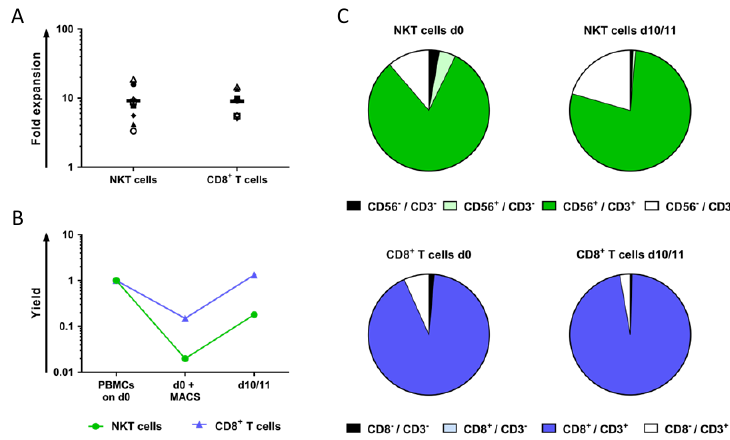
Figure 1. Natural killer T (NKT) cells can be isolated from peripheral blood mononuclear cells (PBMCs) and expanded by using CD3 monoclonal antibody (OKT-3) and interleukin-2 (IL-2). The NKT cells were derived from peripheral blood mononuclear cells (PBMCs) from healthy donors via magnetic-activated cell sorting (MACS). The CD8 + T cells were obtained from the NKT-negative cell fraction. Both of the cell populations were then stimulated with OKT-3 and IL-2 for 10 – 11 days. During expansion, IL-2 was added on days 2, 3, 5, and 7. The cells were counted on day 3 and re-adjusted to a concentration of 0.2 × 10 6 cells per ml using fresh culture medium. On day 7, the total cell culture volume was doubled by adding fresh culture medium, and half of the total volume was transferred to a second culture flask. After expansion, the cells were counted, and the fold expansion was calculated by dividing final cell count by the initial number of cells at the beginning of stimulation. Prior to and after expansion, the NKT cells were double stained for CD56 and CD3, and the CD8 + T cells were double stained for CD8 and CD3. ( A ) The fold expansions of 7 – 8 independent experiments, each depicted as a different symbol, are shown. The resulted values are presented on a logarithmic scale. The mean values are shown as bars. ( B ) Yield of the NKT cells (green circles) and CD8 + T cells (blue triangles) before and after MACS isolation and final expansion with OKT-3 and IL-2 calculated per 1 × 10 6 PBMCs. The resulted values are presented on a logarithmic scale. The average values of 6 – 8 independent experiments are displayed. The absolute values are listed in Table S1. ( C ) The composition of the cell subpopulations at the beginning and the end of expansion. The NKT cells were double stained for CD56 and CD3 (upper part), and the CD8 + T cells were double stained for CD8 and CD3 (lower part). The average values of 6 – 7 independent experiments are shown. The mean percentages of the different populations are listed in Table S2.